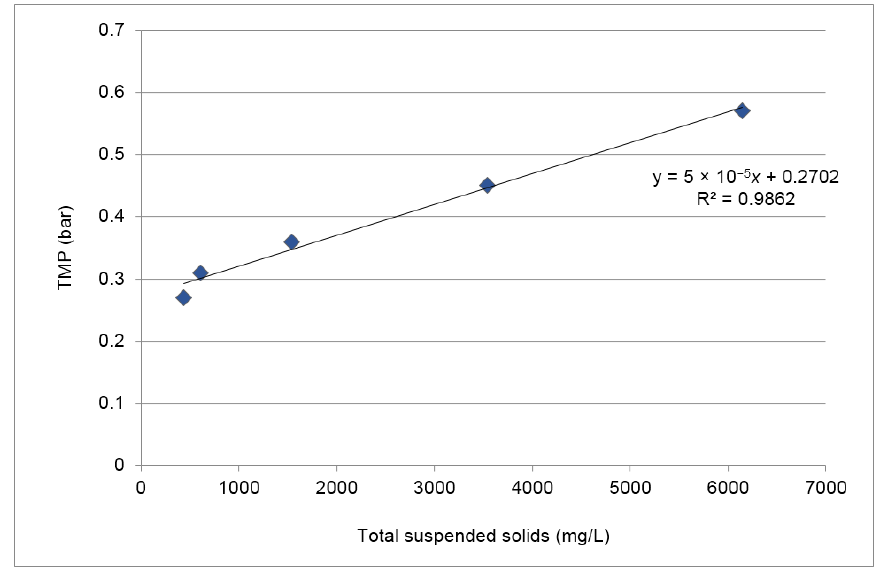
Figure 7. Impact of total suspended solids present in the feed in TMP—Concentration test.